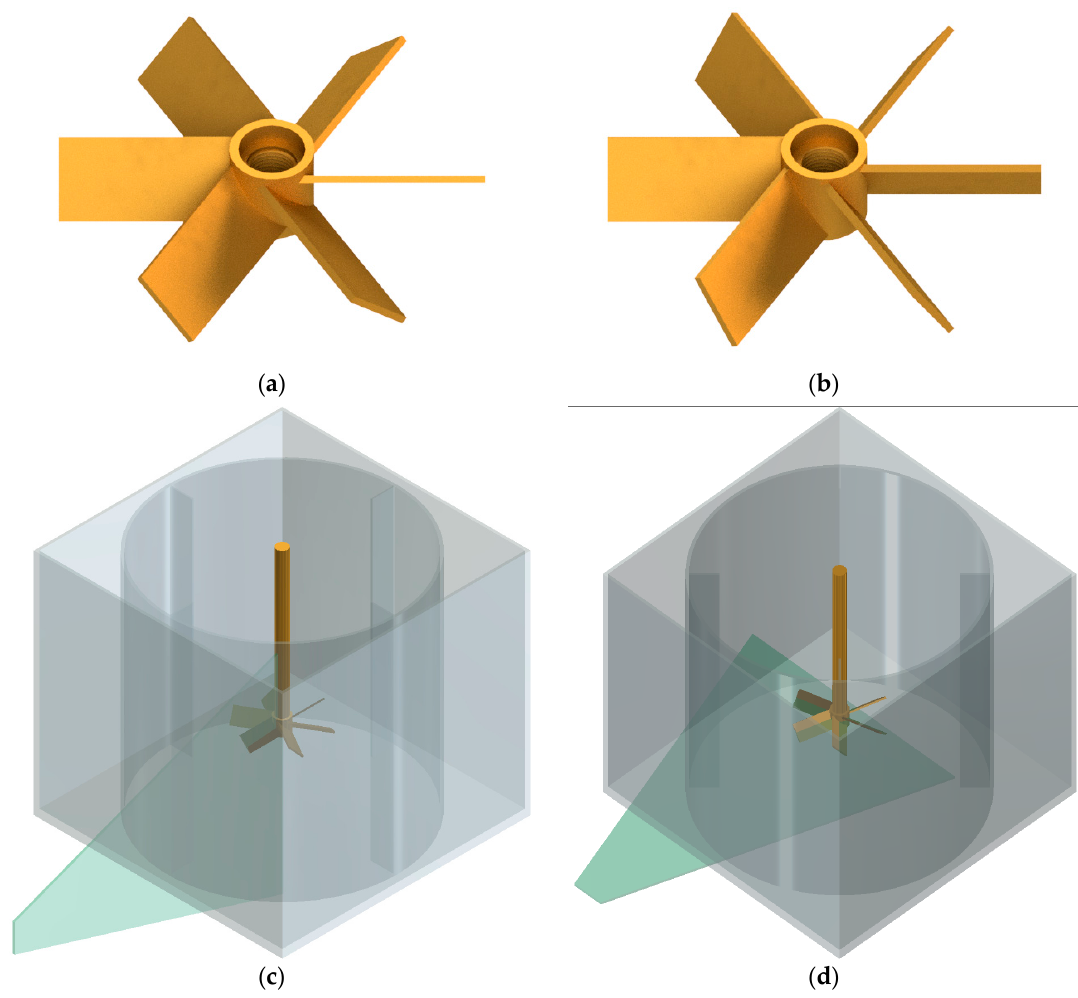
Figure 2. Tested impellers ( a ) PBT45, ( b ) PBT60 and the position of the light knife during the measurements, ( c ) vertical: measurement of radial and axial components, ( d ) horizontal: measurement of tangential and radial components.